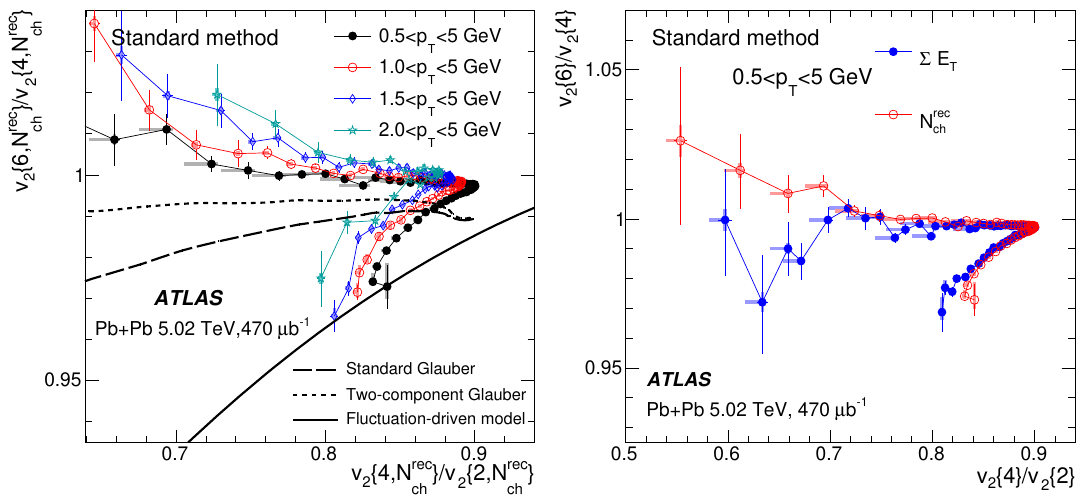
Figure 34 . The correlation between v 2 f 6 g =v 2 f 4 g and v 2 f 4 g =v 2 f 2 g for four p T ranges calculated with event class based on N rec with models based on initial-state eccentricies (left panel), as well as ch the correlation compared between the (cid:6) E T event class and N rec event class for 0 : 5 < p T < 5 GeV ch (right panel). The error bars and shaded boxes represent the statistical and systematic uncertainties, respectively.